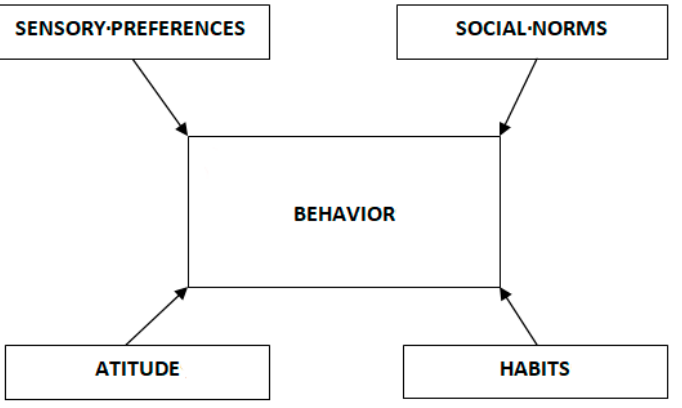
Figure 3. The design of research hypotheses for a social survey of wine tourism